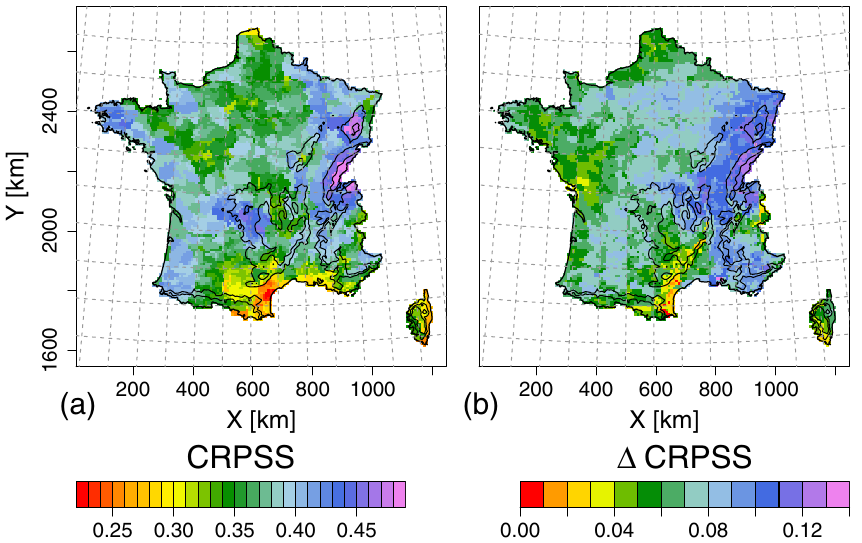
Figure 4. (a) CRPSS obtained with SCAMP (best possible value = 1). (b) CRPSS gain obtained with SCAMP compared to AM 25